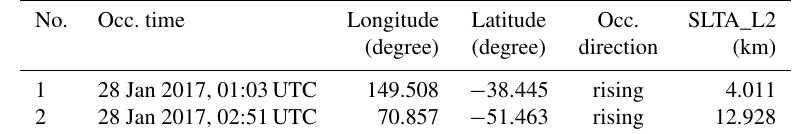
Table 3. Details of the good profiles.